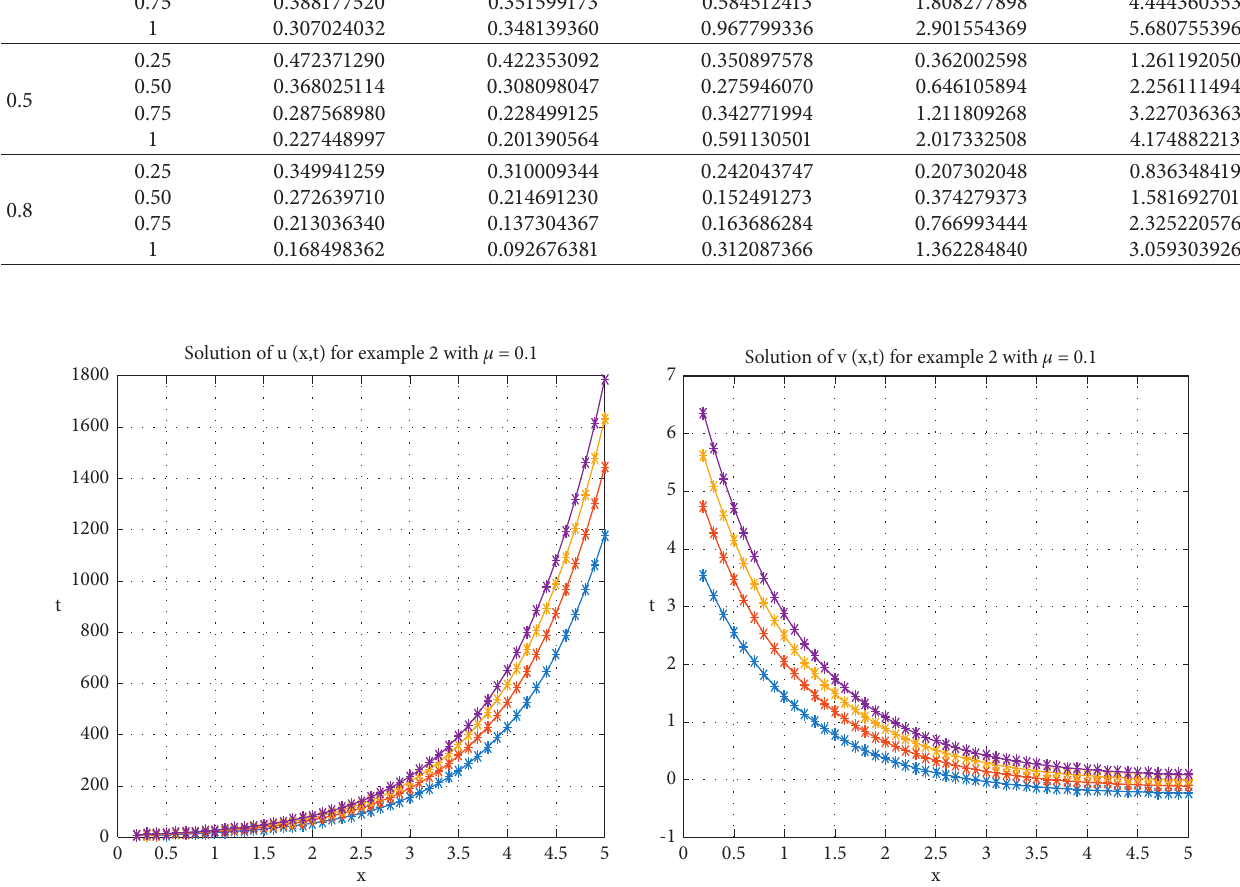
Figure 3: 2D graphical representation for u ( t, x ) and v ( t, x ) of equation